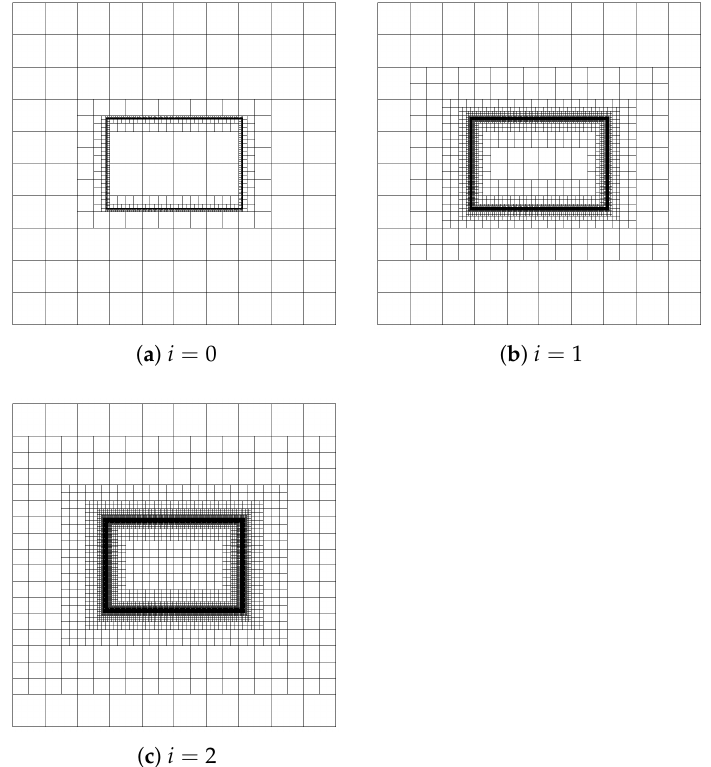
Figure 18. Horizontal refinement with different bandwidth. ( a ) Only the cut cells are refined. ( b ) First-order refinement: the cut cells and their first nearest neighbors are refined. ( c ) Second-order refinement: the cut cells and up to their second nearest neighbors are